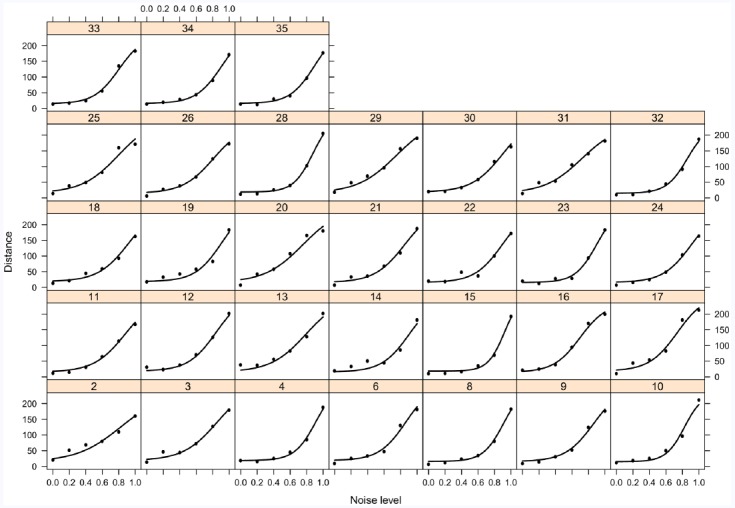
Figure A1. Task performance (distance to target) plotted as functions of noise level for each participant. Four-parameter sigmoid functions were fitted to the data.